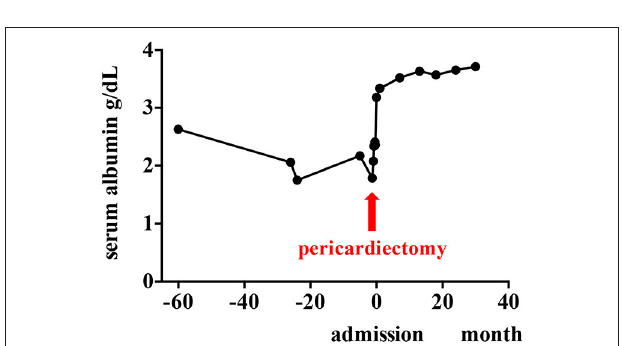
FIGURE 5 | Clinical course of the patient. Serum albumin concentrations are improved after